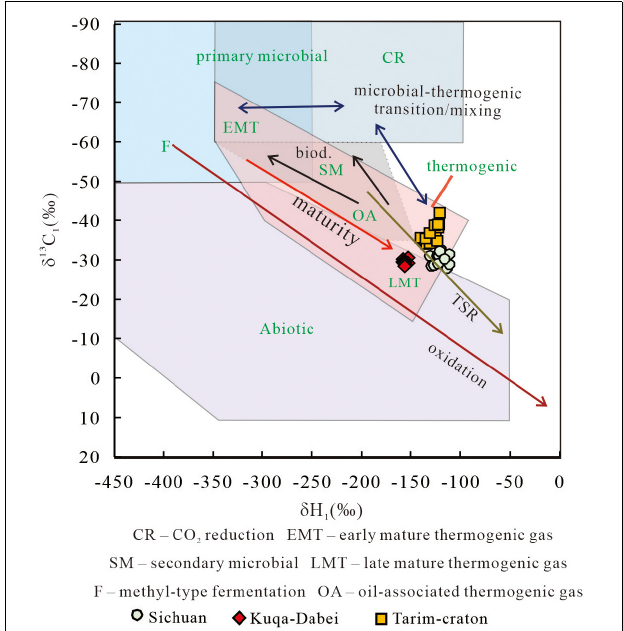
FIGURE 8 | Plot of δ 2 H 1 vs. δ 13 C 1 of gases from Dabei gas field in the Kuqa depression, craton area of Tarim basin and Sichuan basin (Milkov and Etiope, 2018). Data source see section “Samples and Methods” in the